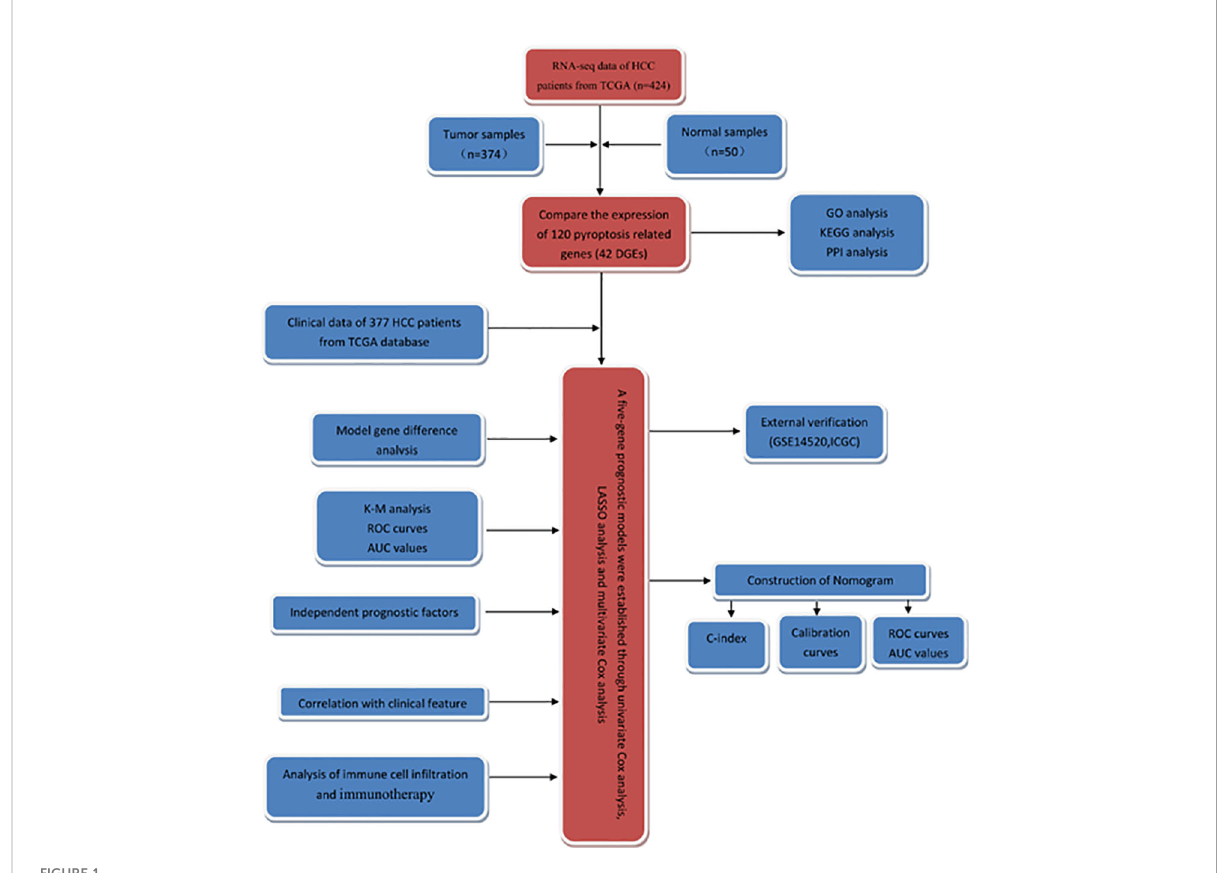
FIGURE 1 The fl owchart of this